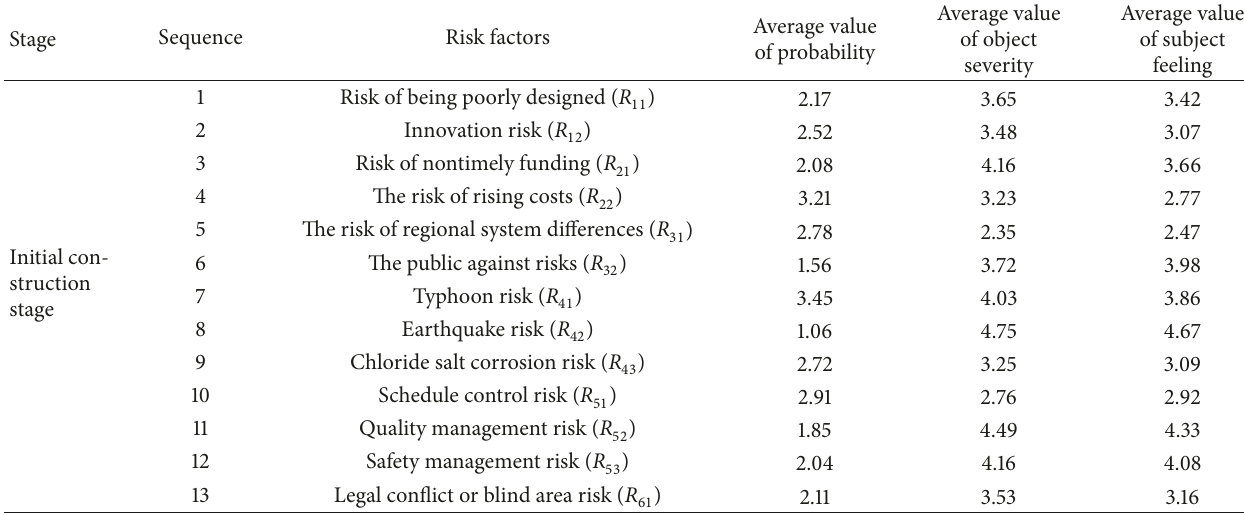
Table 8: Three-dimensional evaluation data of single risk factor in the HZMB initial construction